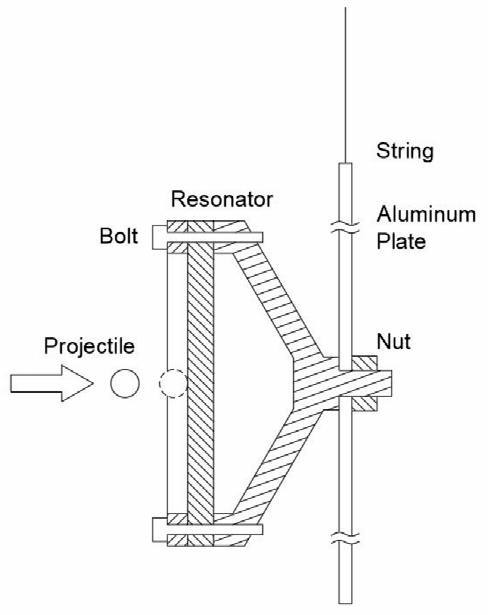
Figure 1. Schematic of pyroshock